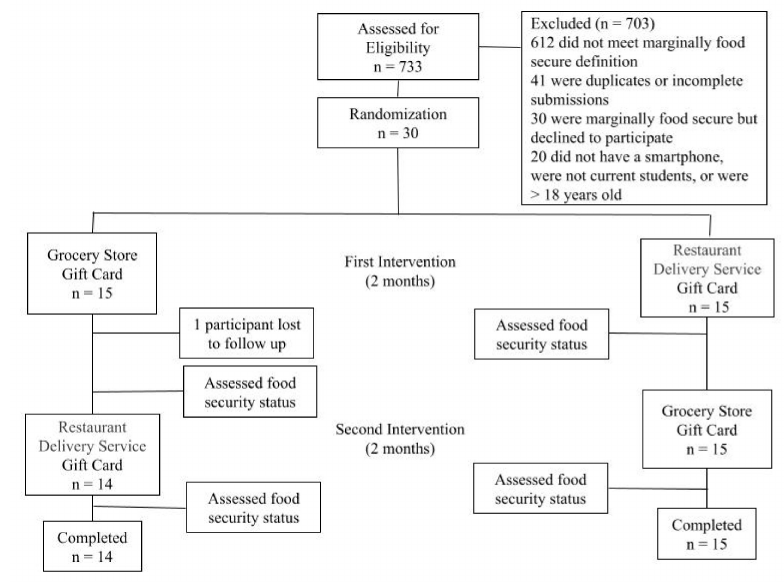
Figure 1. Research study